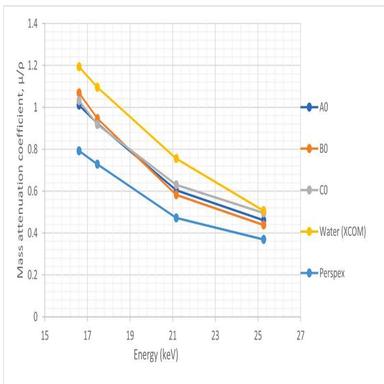
The mass attenuation coefficients of Rhizophora spp. particleboards with 0% adhesive in comparison with water (XCOM) and Perspex ® at energy range of 16.62–25.27 keV.